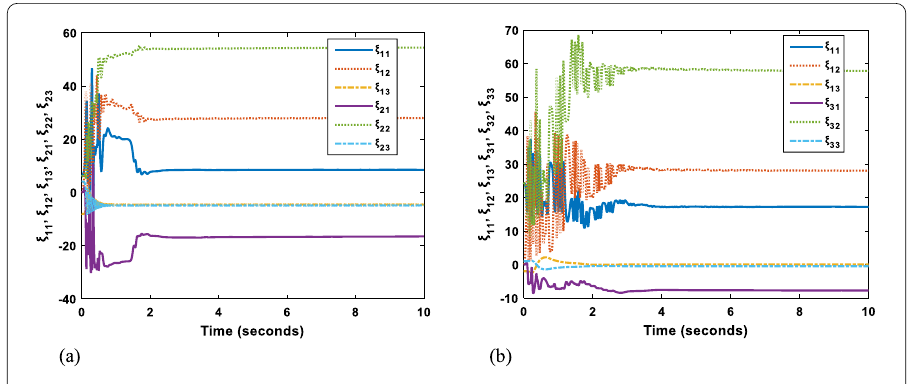
Figure 3 Estimation of master and slave system parameters: ( a ) ξ 11 ( t ), ξ 12 ( t ), ξ 13 ( t ), ξ 21 ( t ), ξ 22 ( t ), ξ 23 ( t ) and ( b ) ξ